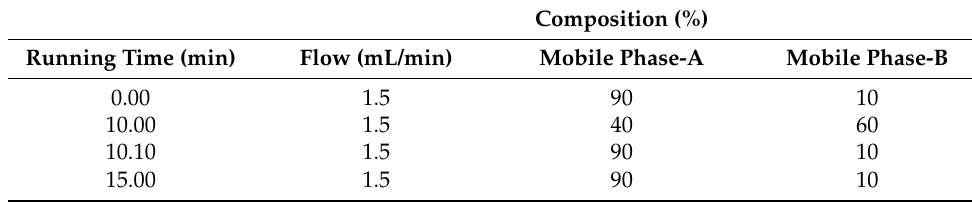
Table 6. HPLC Gradient